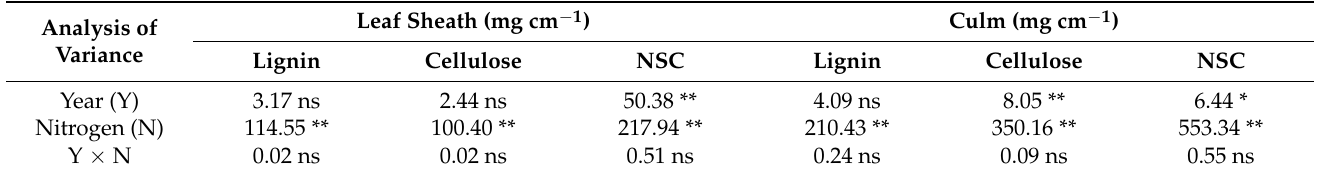
Table 8. Analysis of variance of carbohydrates contents of the S2 basal internode of the culm and